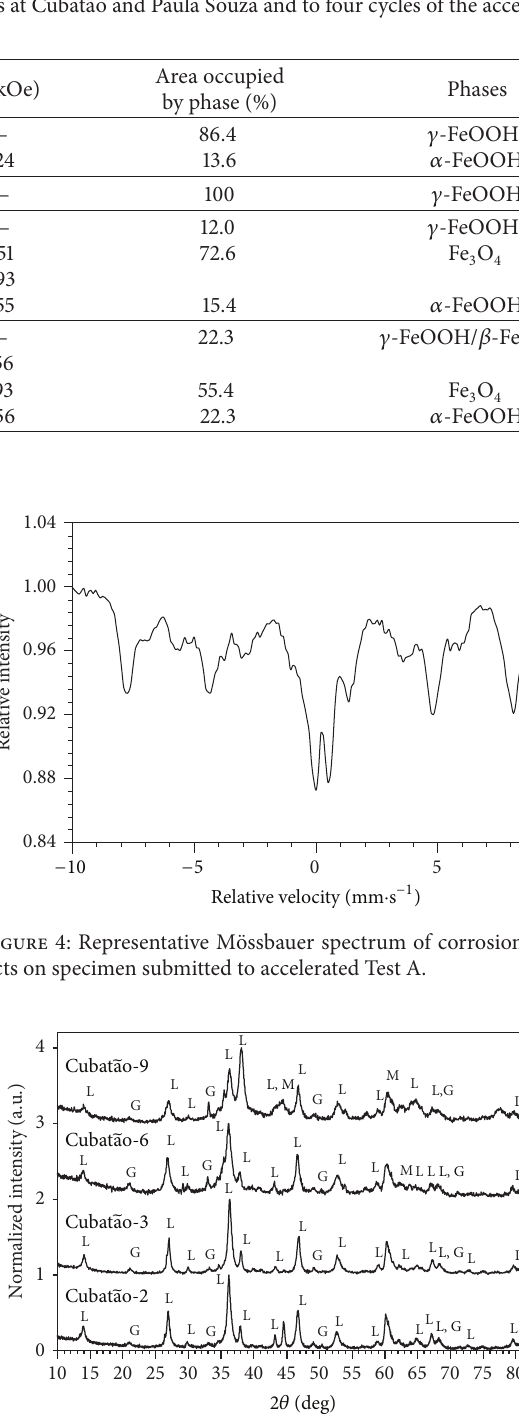
Figure5:XRDpatternsofspecimensexposedinCubat˜aostationfor different periods. G = goethite; L = lepidocrocite; M =